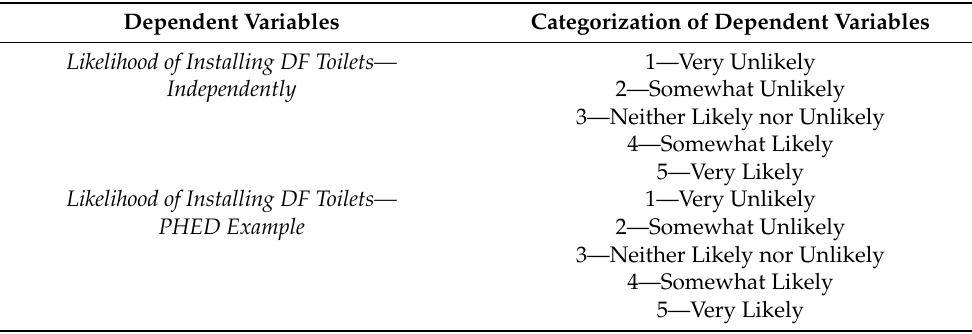
Table 6. Categorization of dependent variables for MANOVA